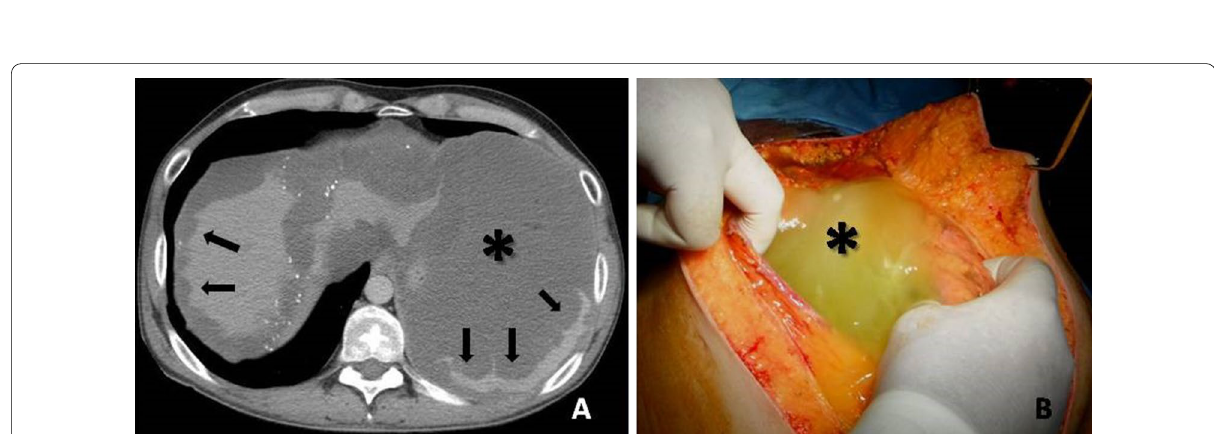
Fig. 16 a Contrast-enhanced CT image reveals low-attenuation intraperitoneal gelatinous fluid (asterisk) with mass-like effect and scalloping of the surface of the liver and spleen (arrows). Multiple small calcifications are also present. b Intraoperative photograph shows thick gelatinous fluid filling the peritoneal cavity